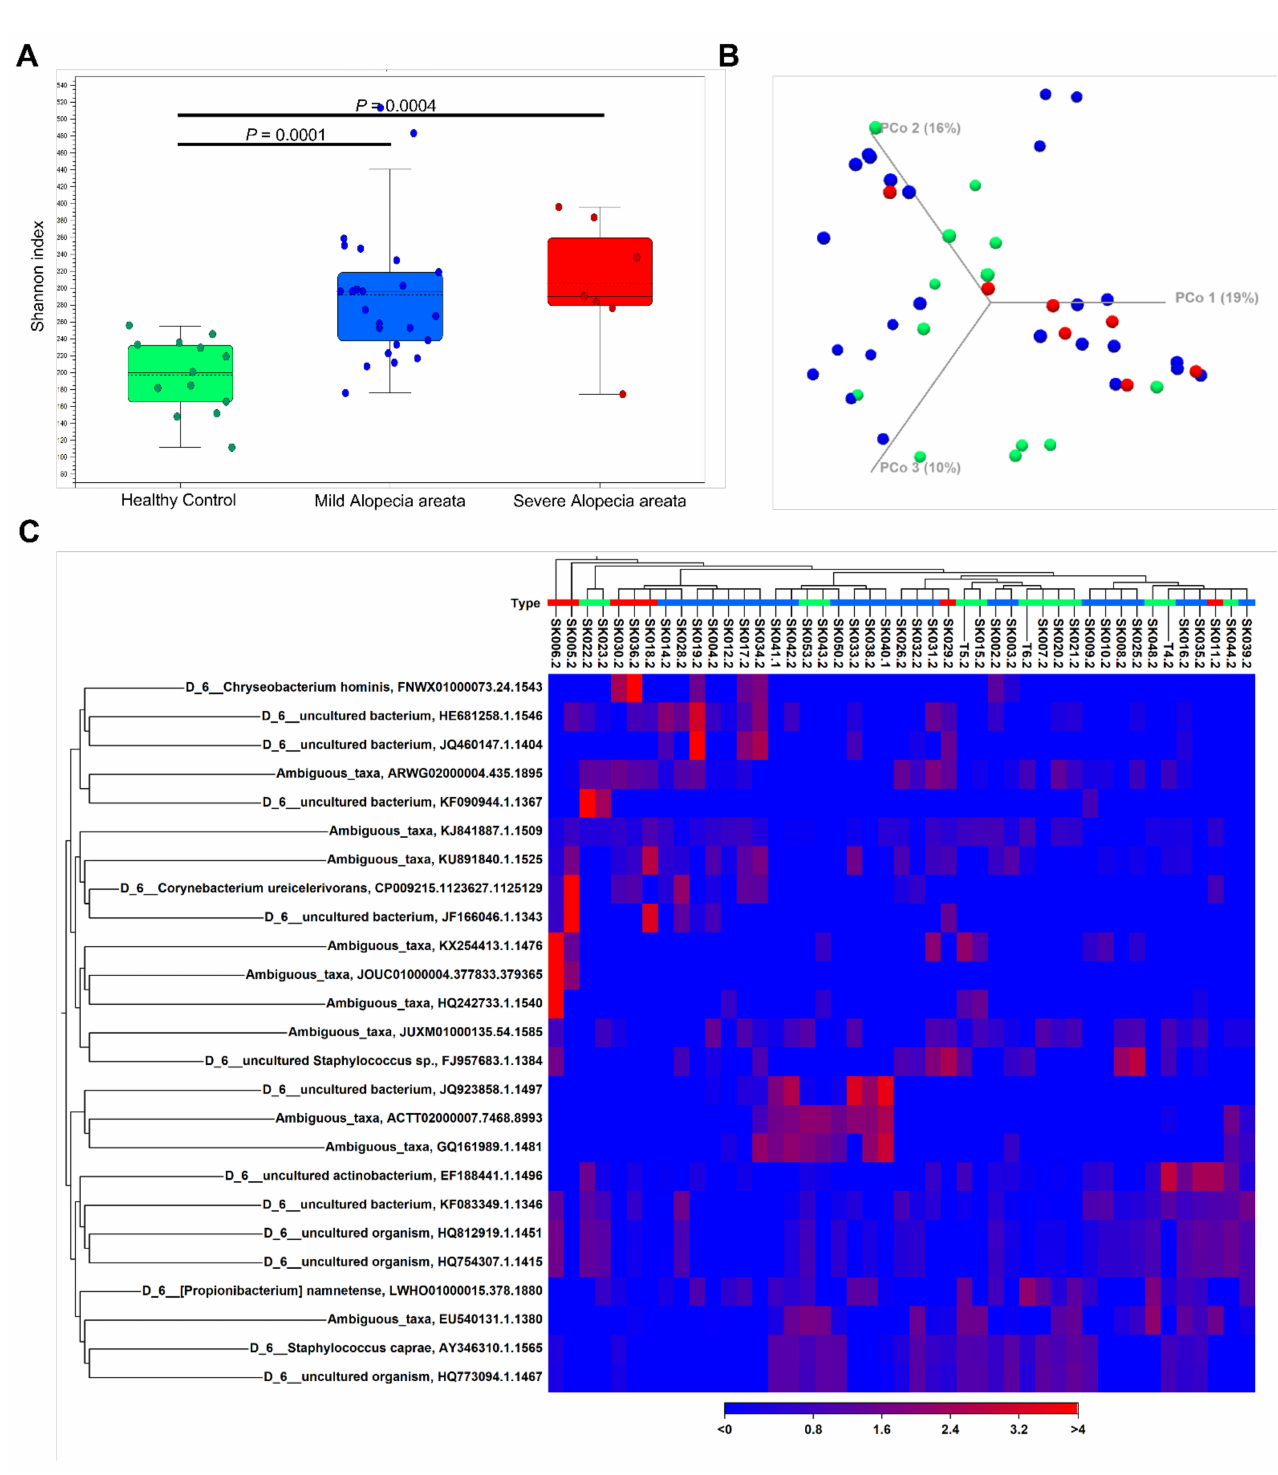
Figure 1. The alpha diversity and beta diversity indices of scalp microbiome between alopecia areata (AA) with different prognosis and healthy control (HC). ( A ) The significantly higher Shannon index was found in the AA patients than in the HC. There was no significant difference in the alpha diversity according to the prognosis among the AA patients. Statistical analysis was performed by a Mann–Whitney U-test. Plotted are interquartile ranges (IQRs; boxes), medians and means